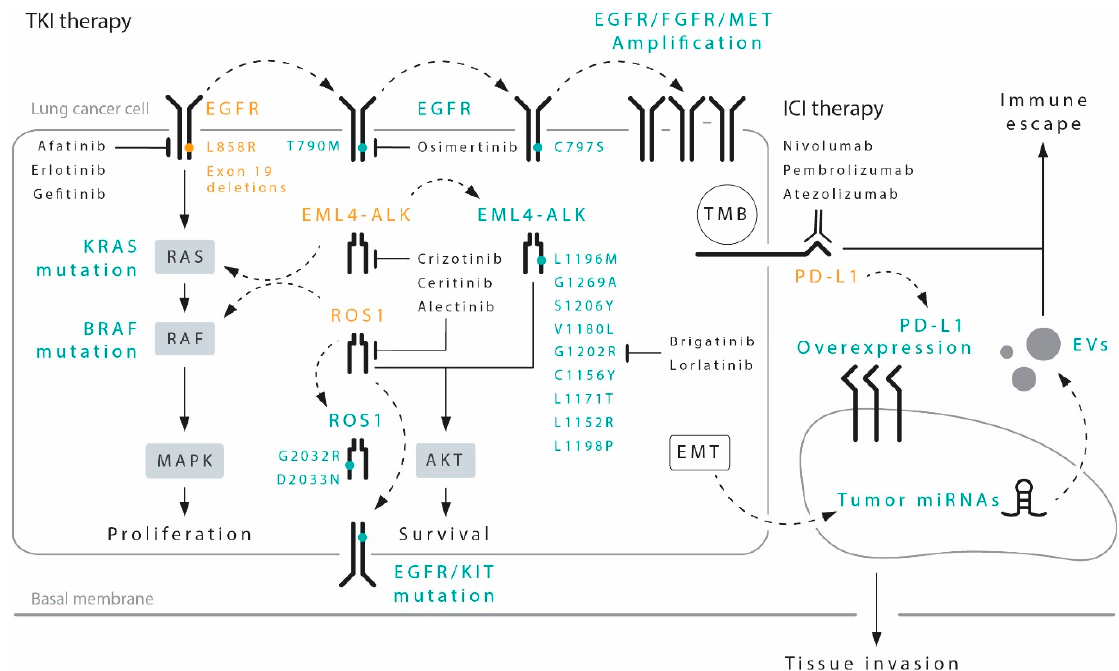
Figure 1. Most relevant targeted therapies and immune checkpoint inhibitor (ICIs) in non-small-cell lung cancer (NSCLC), with the principal targets highlighted (in orange) and the most recurrent resistance mechanisms (in green) potentially detectable by liquid biopsy. EGFR, epidermal growth factor receptor; KIT, c-Kit proto-oncogene receptor tyrosine kinase; MET, c-Met proto-oncogene; EML4-ALK, echinoderm microtubule associated protein-like 4-anaplastic lymphoma kinase; ROS1, ROS1 proto-oncogene receptor tyrosine kinase; EV, extracellular vesicles.